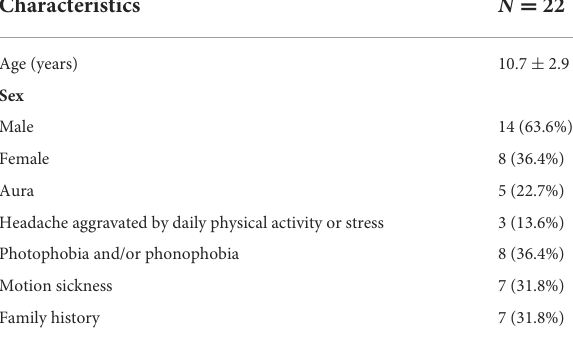
TABLE 1 Characteristics of patients with VMC.